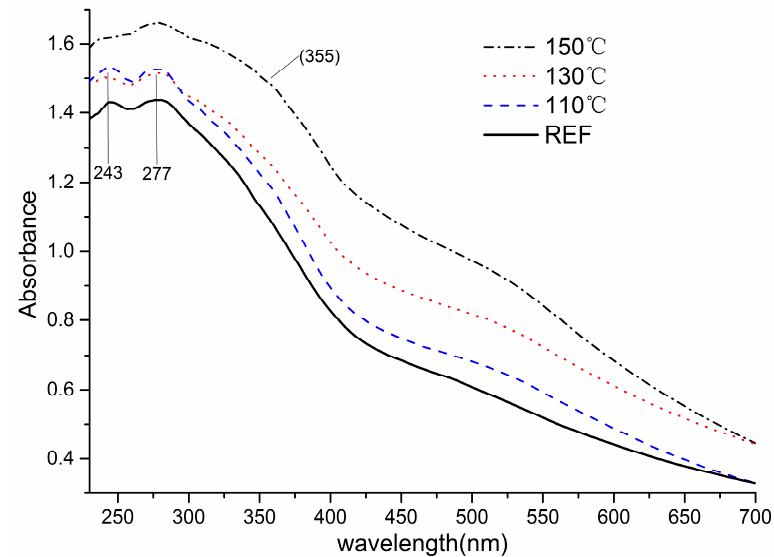
Figure 2. DRUV-Vis spectrum of wood flours treated in saturated steam.